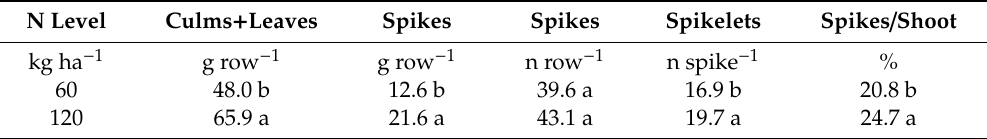
Table 6. Biomass of shoot plant parts, and spike yield components in triticale, as a ff ected by the N level mean e ff ect. For each parameter, values followed by the same letter within a column are not significantly di ff erent at P < 0.05, Tukey’s test.